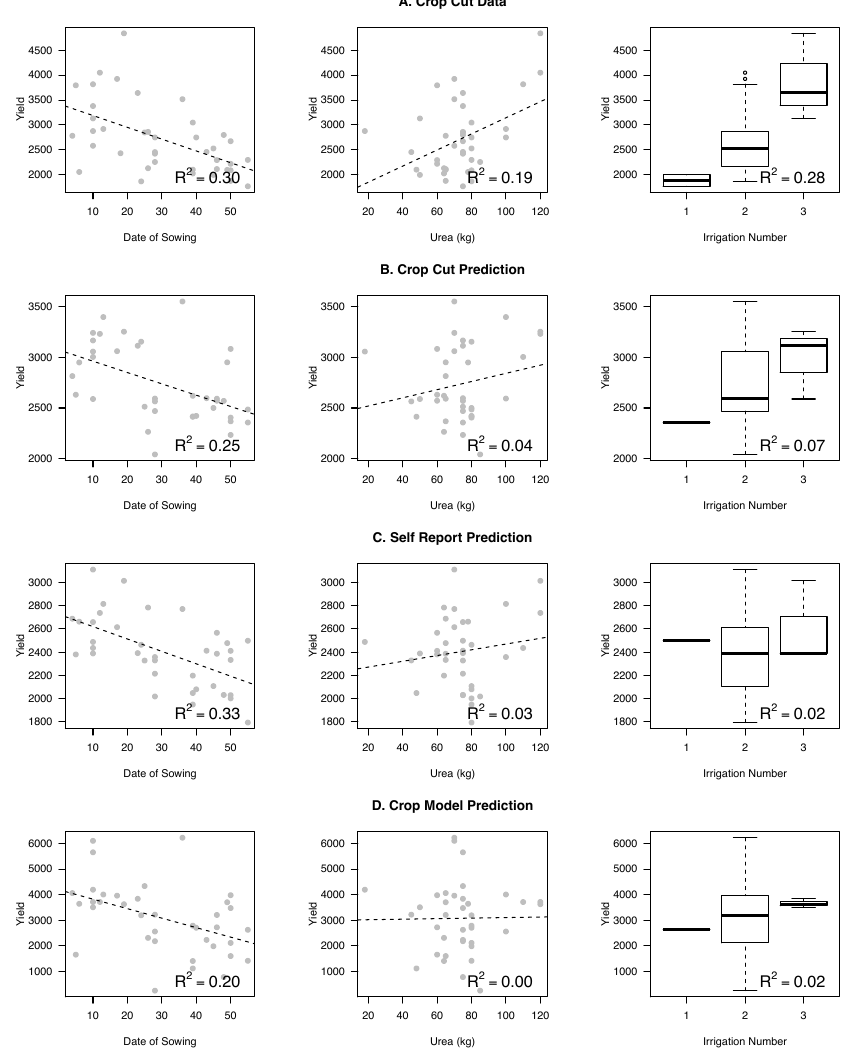
Figure 6. The relationship between yields and sow date, urea fertilizer added, and number of irrigations for 2014–2015 data: ( A ) known relationships between these management variables and yield as measured using the crop cut yield data collected in the field; ( B ) relationships with yield estimates using the crop cut parameterized model; ( C ) relationships with yield estimates using the self-report model; and ( D ) relationships with yield estimates using the crop model parameterized model. R 2 between management variables and yield are highlighted in each